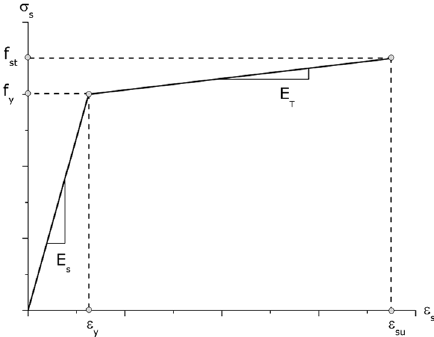
Figure 10. Stress–strain relation for steel reinforcements in tension.